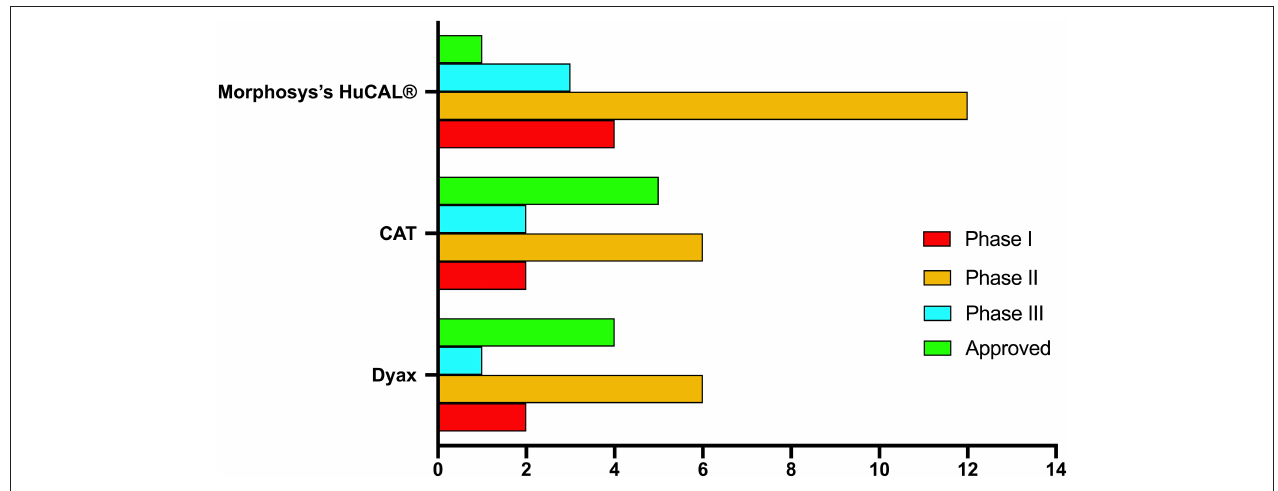
FIGURE 4 | Highest development phase achieved for antibodies isolated from various major company-owned libraries.